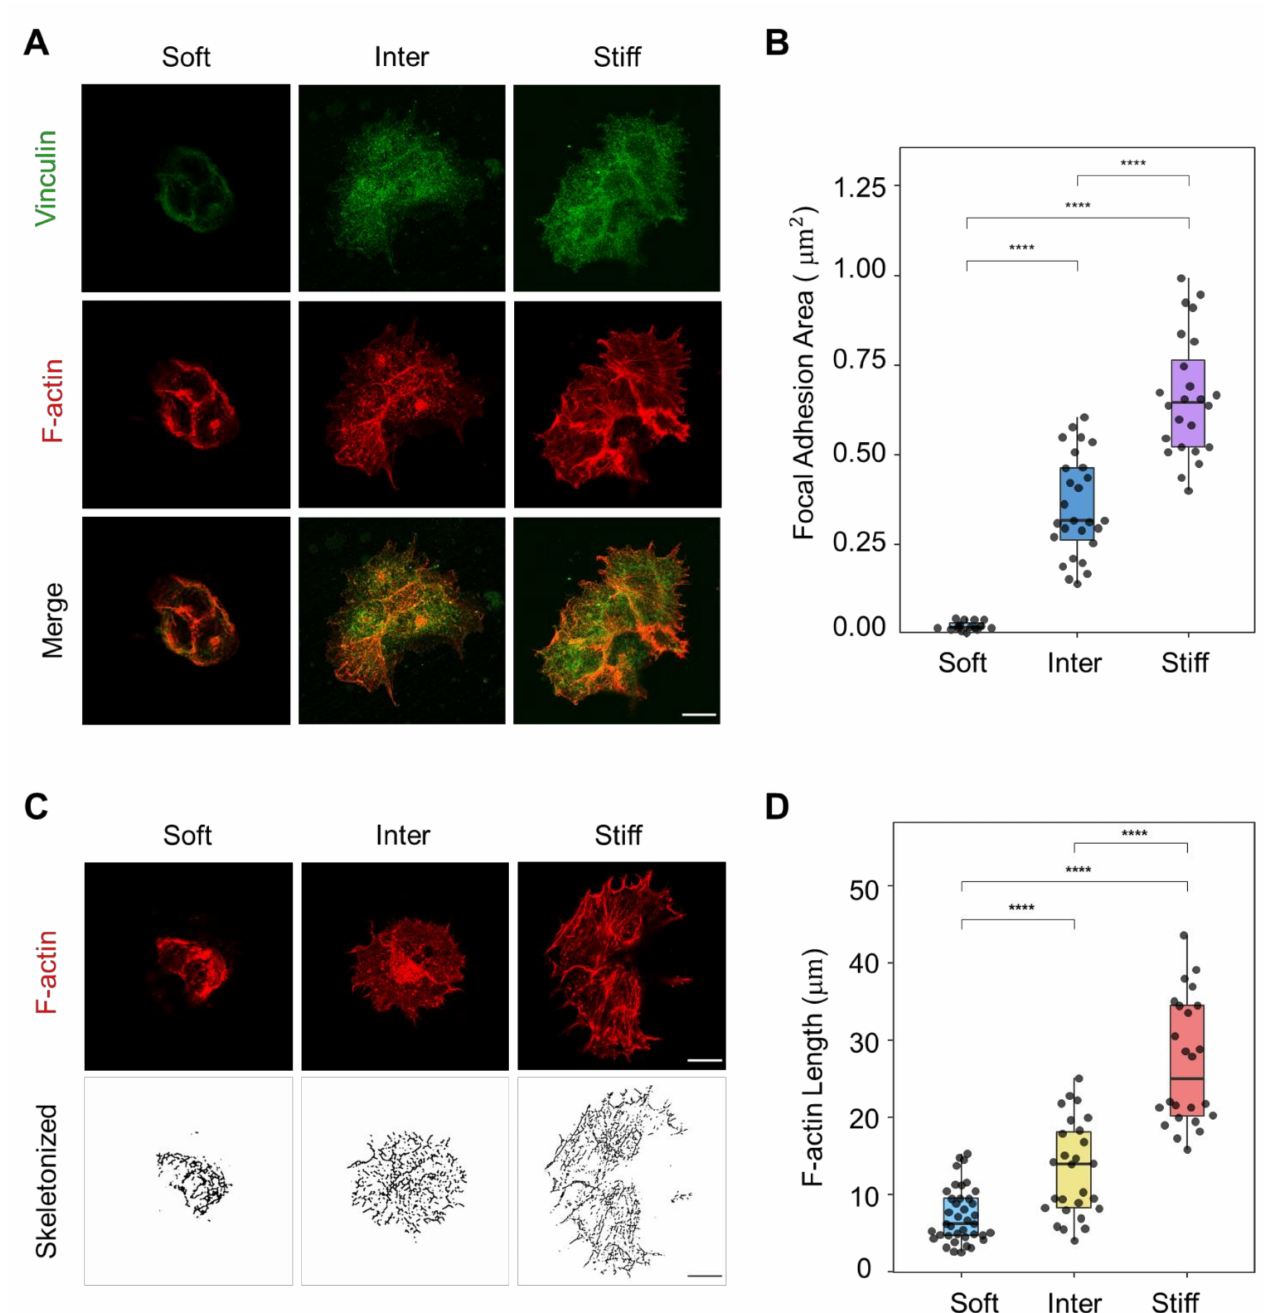
Figure 2. F-actin organization and focal adhesion formation are affected by simulated ECM stiffness in JAR cells. ( A ) Immunofluorescence staining of JAR cells cultured on different regions (red: F-actin; green: vinculin, scale bar: 20 µ m). ( B ) Measured focal adhesion area of JAR cells cultured on dif- ferent regions. **** 1 × 10 − 6 , n = 18, 27, 24 for Soft, Inter, and Stiff, respectively. Data reported as mean ± standard deviation for N = 3 independent experiments. Each scatter indicates each focal adhesion being measured. ( C ) Skeletonization of F-actin in JAR cells cultured on different regions (scale bar: 20 µ m). ( D ) Measured cytoskeleton length of JAR cells cultured on different regions. **** 1 × 10 − 6 , n = 35, 27, 24 for Soft, Inter, and Stiff, respectively. Data reported as mean ± stan- dard deviation for N = 3 independent experiments. Each scatter indicated each F-actin filament being